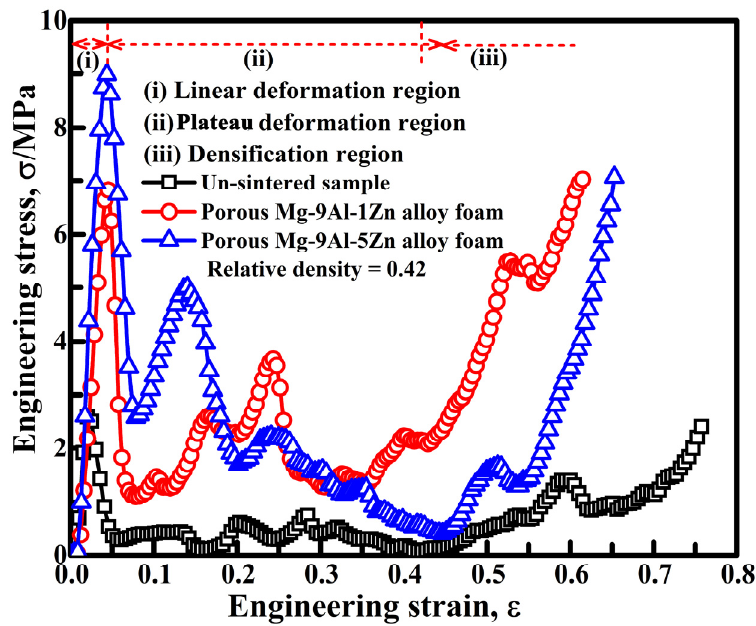
Figure 10. Compressive stress–strain curves of the un-sintered sample, porous Mg-9Al-1Zn alloy foam sample and porous Mg-9Al-5Zn alloy foam sample with equivalent relative density (R. D. = 0.42).